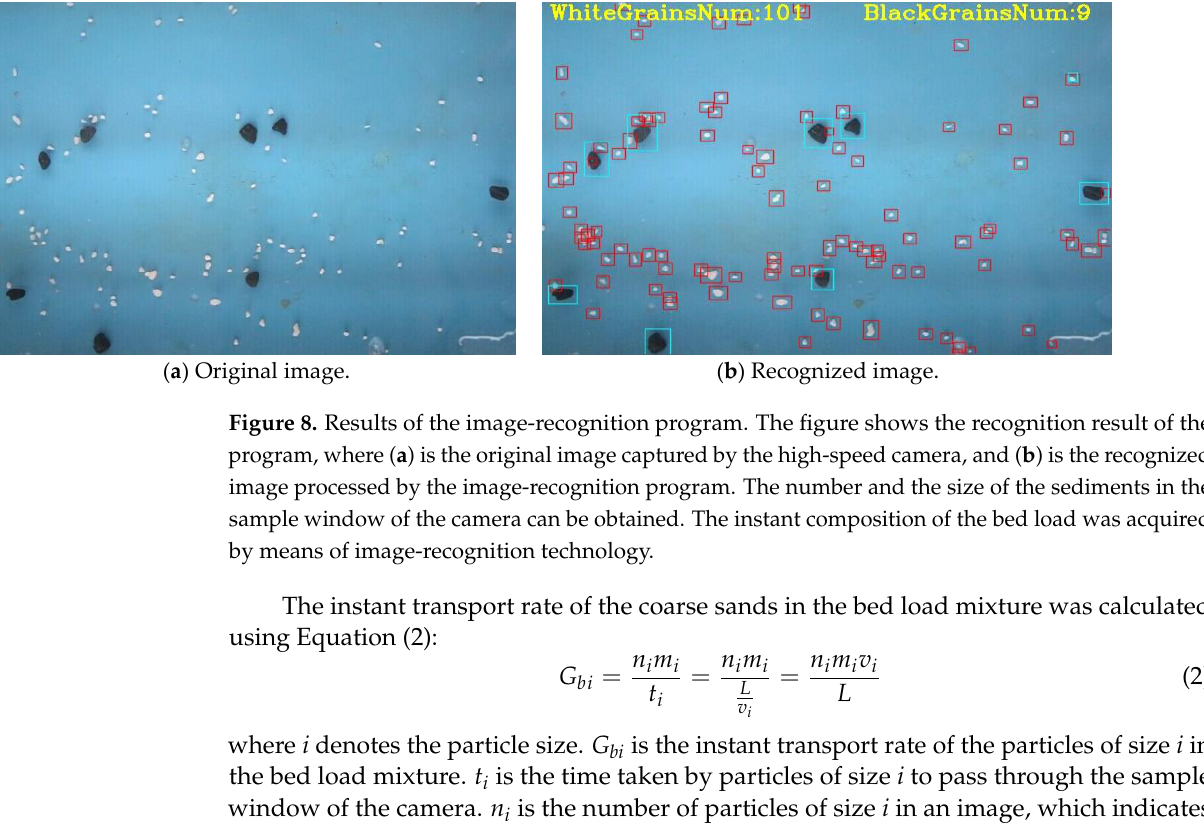
Figure 7. Experimental installation for collecting the transporting sediment. The figure shows the image-collection process of the moving particles. When the particles pass through the collecting region, the high-speed camera takes pictures of them and then transports them to the computer to be recognized by the special recognition system.